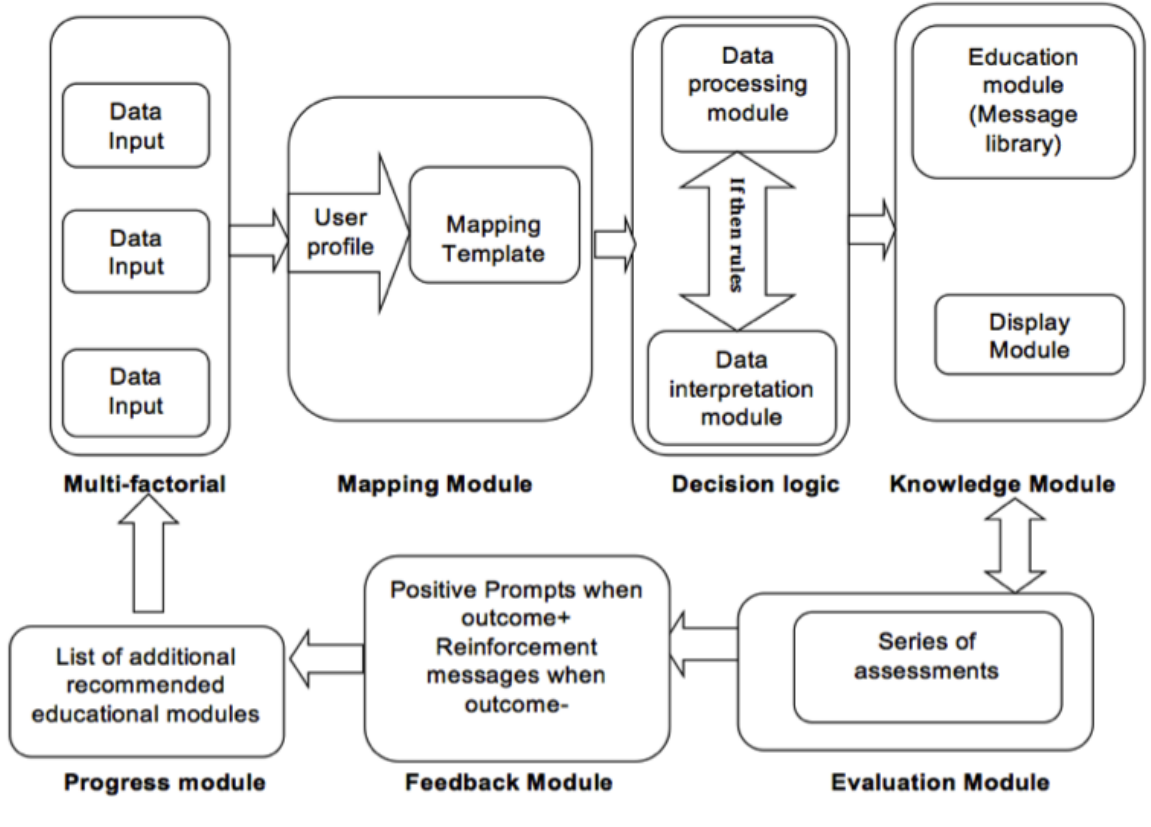
Figure 2. PEMT tailoring